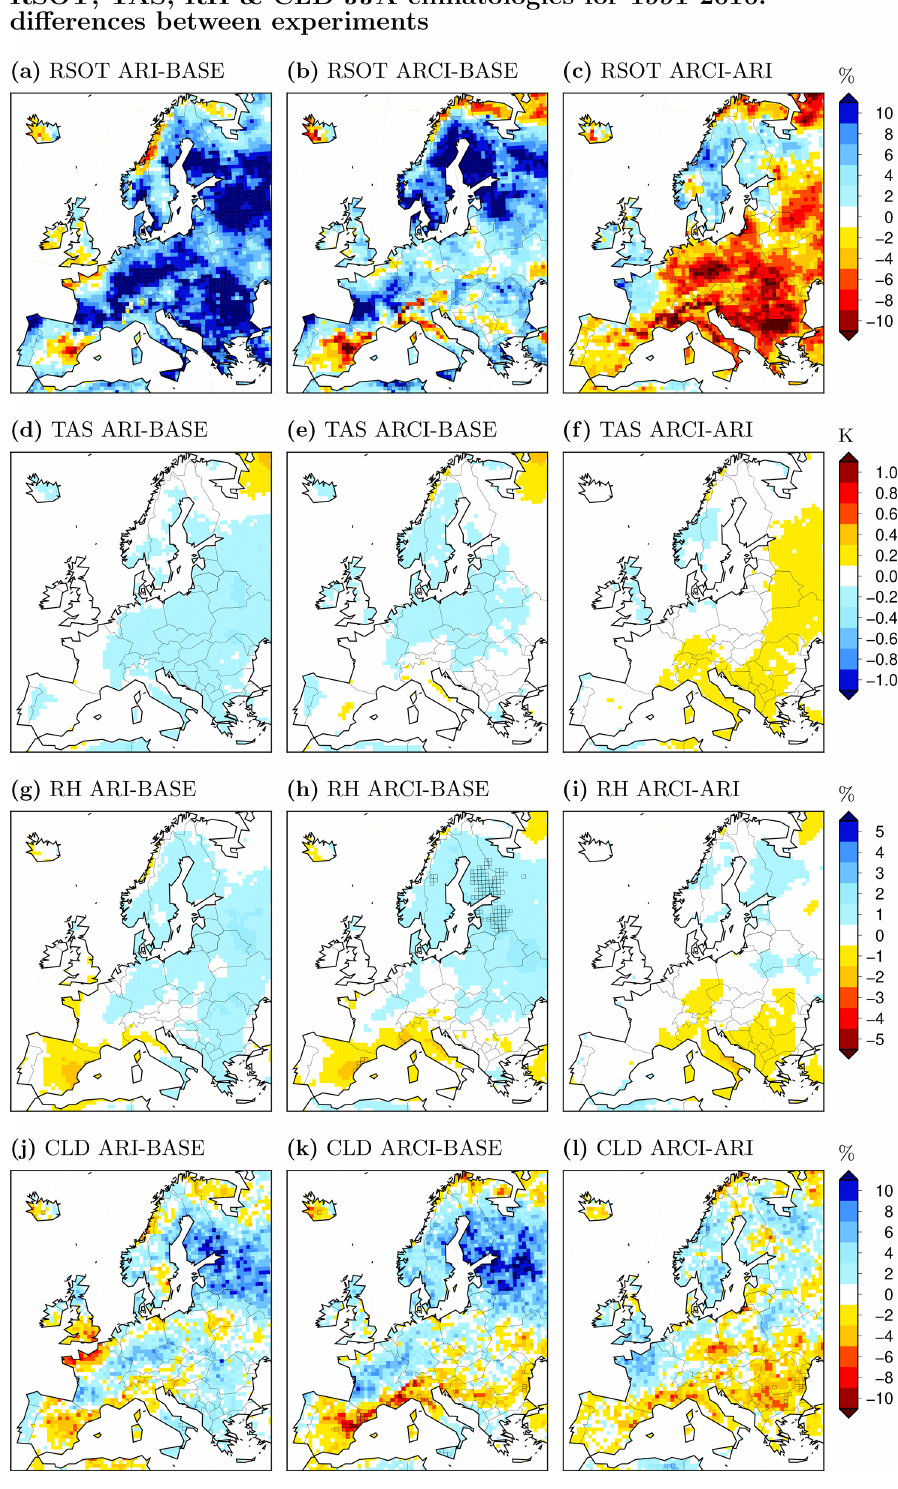
Figure 3. Relative differences between the WRF simulations in the top-of-the-atmosphere outgoing shortwave radiation (RSOT, a – c ), surface (2m height) air temperature (TAS, d – f ), surface (1000hPa pressure level) relative humidity (RH, g – i ) and number of cloudy days (CLD; defined as days with mean CCT > 75%, j – l ) for summer (JJA) climatologies in the historical period (1991–2010); squared if statistically significant ( p < 0.05). Units: Kelvin (K) for TAS and percent for RSOT, RH and